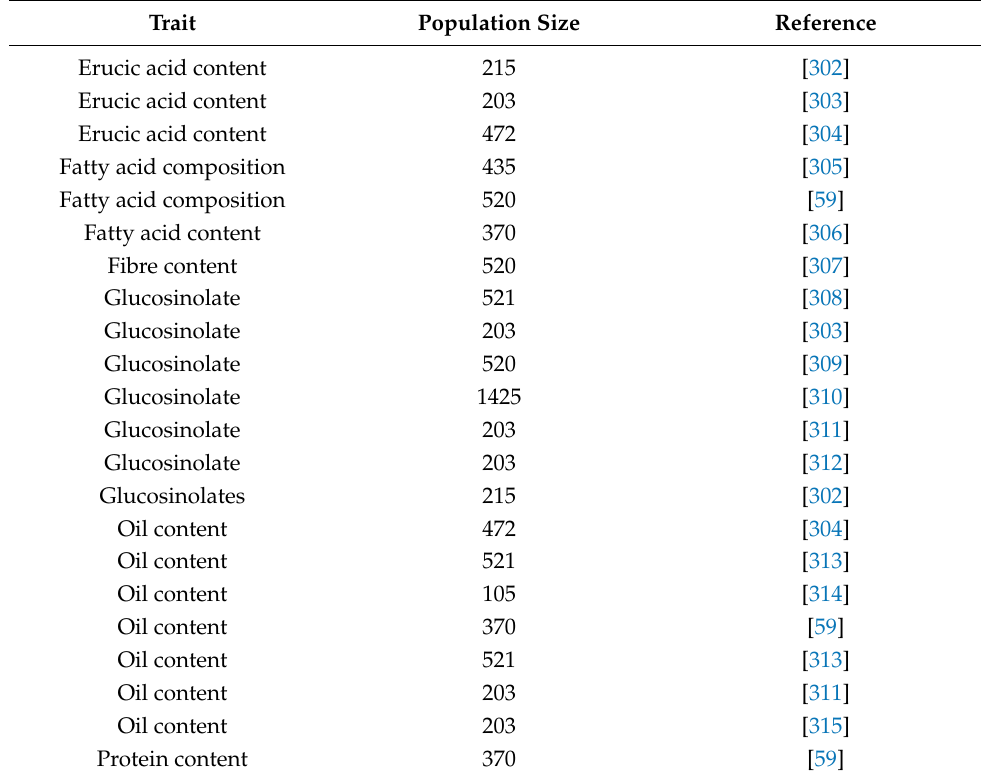
Table 7. Genome-wide association studies have been successfully implemented in Brassica napus L. to identify single-nucleotide polymorphism (SNP) markers associated with seed quality traits. Studies listed in this table were performed using populations of various sizes and genotypic data acquired using the Brassica 60K Illumina Infinium™ SNP genotyping array